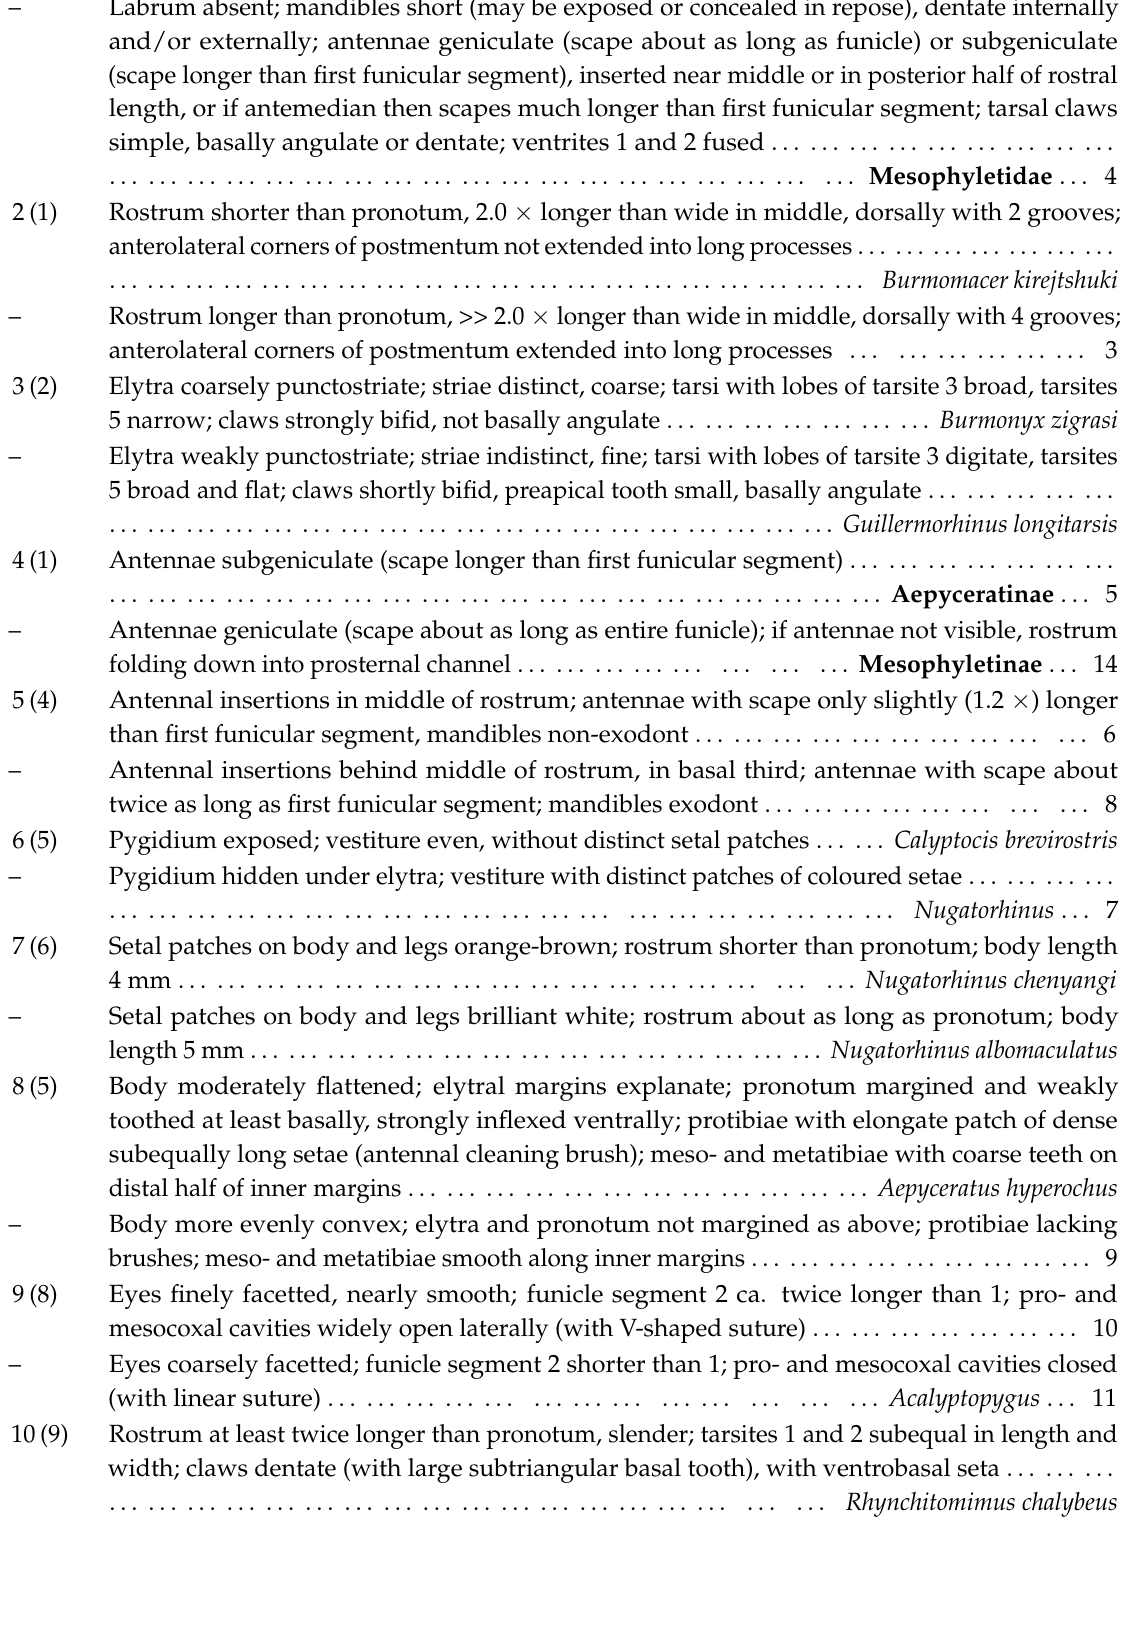
– Rostrum longer than pronotum, >> 2.0 × longer than wide in middle, dorsally with 4 grooves; anterolateral corners of postmentum extended into long processes . . . . . . . . . . . . . . . . . . 3 Elytra coarsely punctostriate; striae distinct, coarse; tarsi with lobes of tarsite 3 broad, tarsites 5 narrow; claws strongly bifid, not basally angulate . . . . . . . . . . . . . . . . . . . . . Burmonyx zigrasi Elytra weakly punctostriate; striae indistinct, fine; tarsi with lobes of tarsite 3 digitate, tarsites 5 broad and flat; claws shortly bifid, preapical tooth small, basally angulate . . . . . . . . . . . . . . .